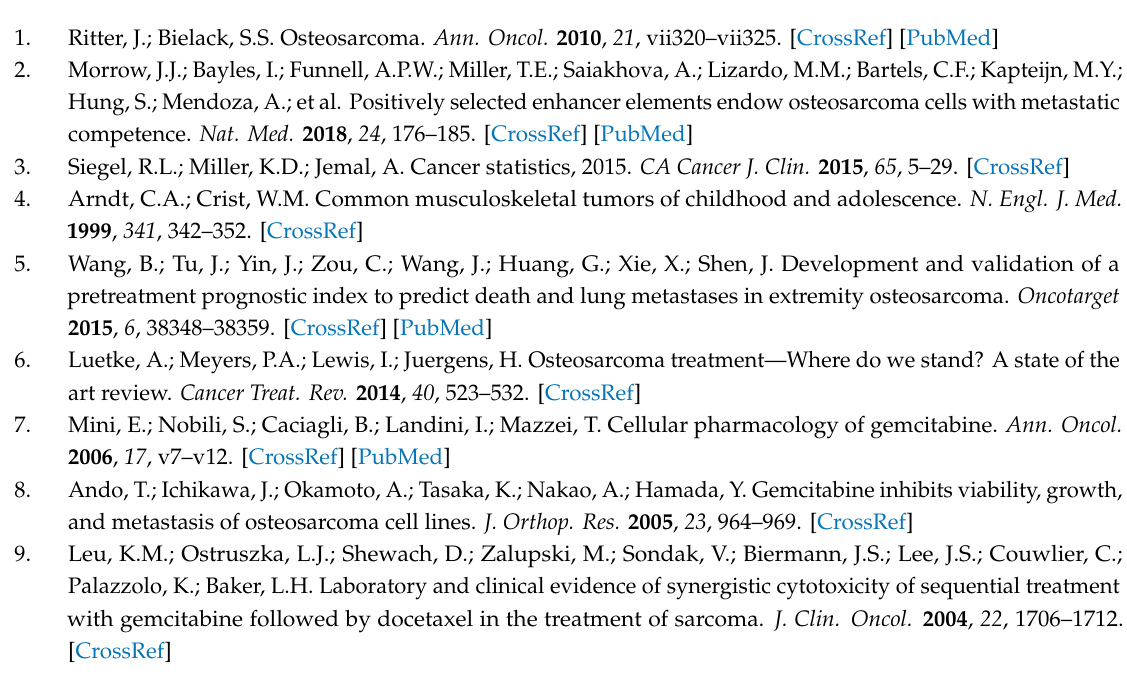
Figure S1: (a–c) Cell viability of osteosarcoma (OS) cells and human osteoblastic cells. (d) Schematic of the cell invasion assay methodology, Figure S2 and S3: Uncropped Western Blot images, Figure S4: Quantification of cleaved caspase 3, cleaved caspase 8, and GAPDH bands in western blots depicted in Figure 2d. (a) LM8 cells. (b) 143B cells, Figure S5: and S6: Uncropped Western Blot images, Figure S7: Quantification of western blot bands corresponding to p62, LC3-I / II, p-RICTOR, RICTOR, p-P70-S6, P70-S6, and GAPDH in LM8 cell lysates depicted in Figure 3a, Figure S8: Quantification of western blot bands of p62, LC3-I / II, p-RICTOR, RICTOR, p-P70-S6, P70-S6, and GAPDH in 143B cell lysates depicted in Figure 3a, Figure S9: (a) Schematic diagram showing the experimental design for Gem and Rapa treatment of mice with allograft or xenograft osteosarcoma cell transplants. (b) Photos of tumor-bearing mice from Figure